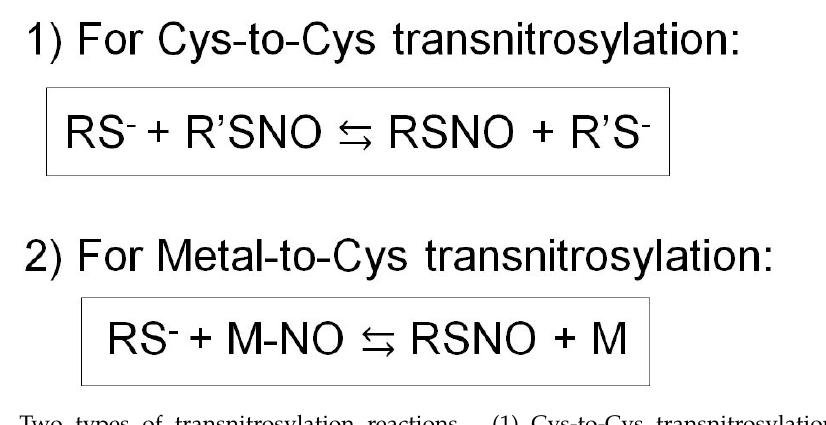
Figure 3. Two types of transnitrosylation reactions. 1) Cys-to-Cys transnitrosylation. 2) Metal-to-Cys transnitrosylation.